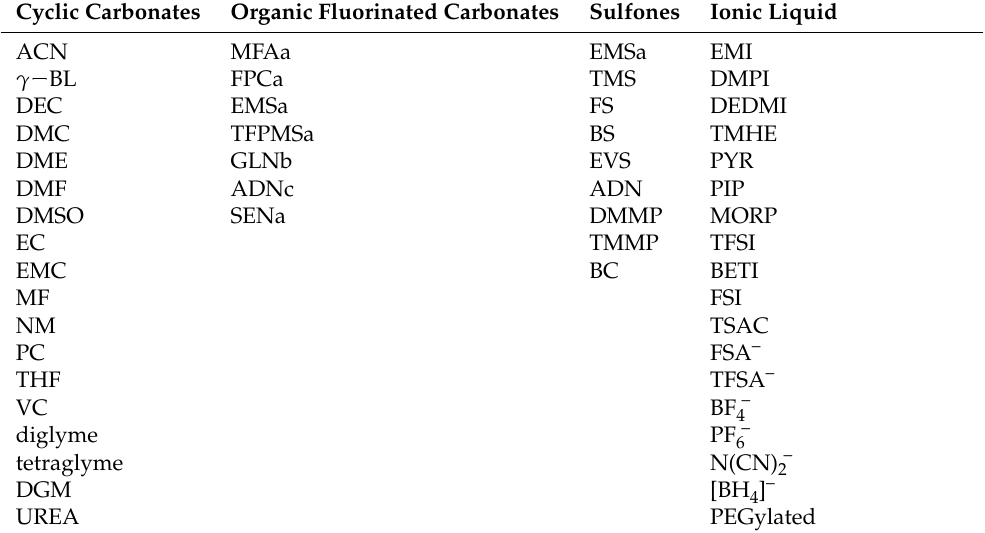
Table 15. Liquid electrolyte solvents.